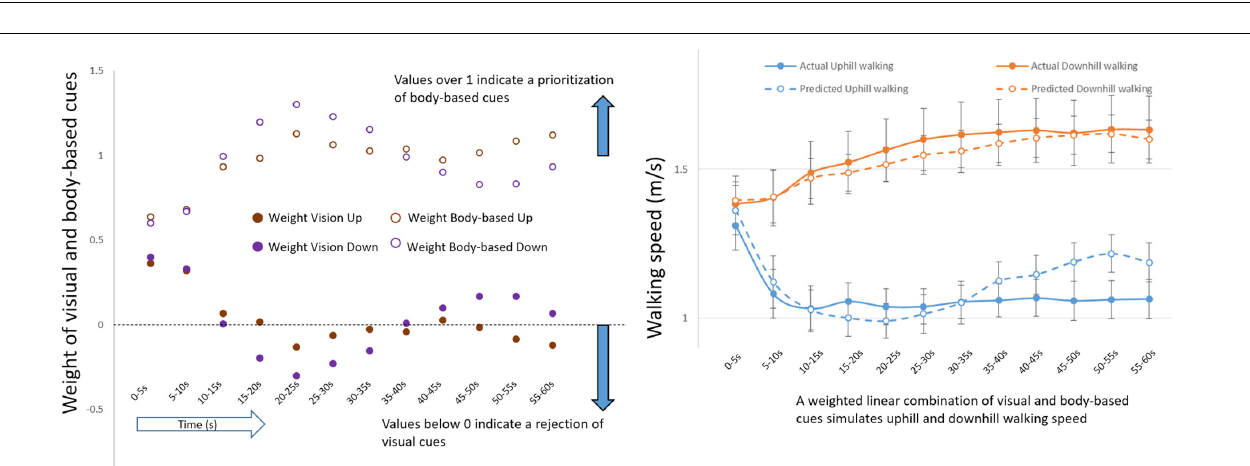
FIGURE 6 | Correlation between early visual shifts and gravity-induced walking adaptation over entire 60-s post-transition period. Correlations (rs) show that vision-induced change in walking speed in the virtual downhill condition (T L V D ) after 5 and 10 s post-transition are significantly correlated with the longer-term gravity-induced changes (characterized by the braking effect) in actual downhill walking (T D V D ). In contrast, change in walking speed induced by uphill visual transition (T L V U ) was correlated with the longer-term gravity-induced changes (characterized by the exertion effect) at only 5 s post-transition. Thus, visual shifts alone (indirectly) predict veridical gravity-induced walking adaptations, with prediction persisting longer for downhill shifts.